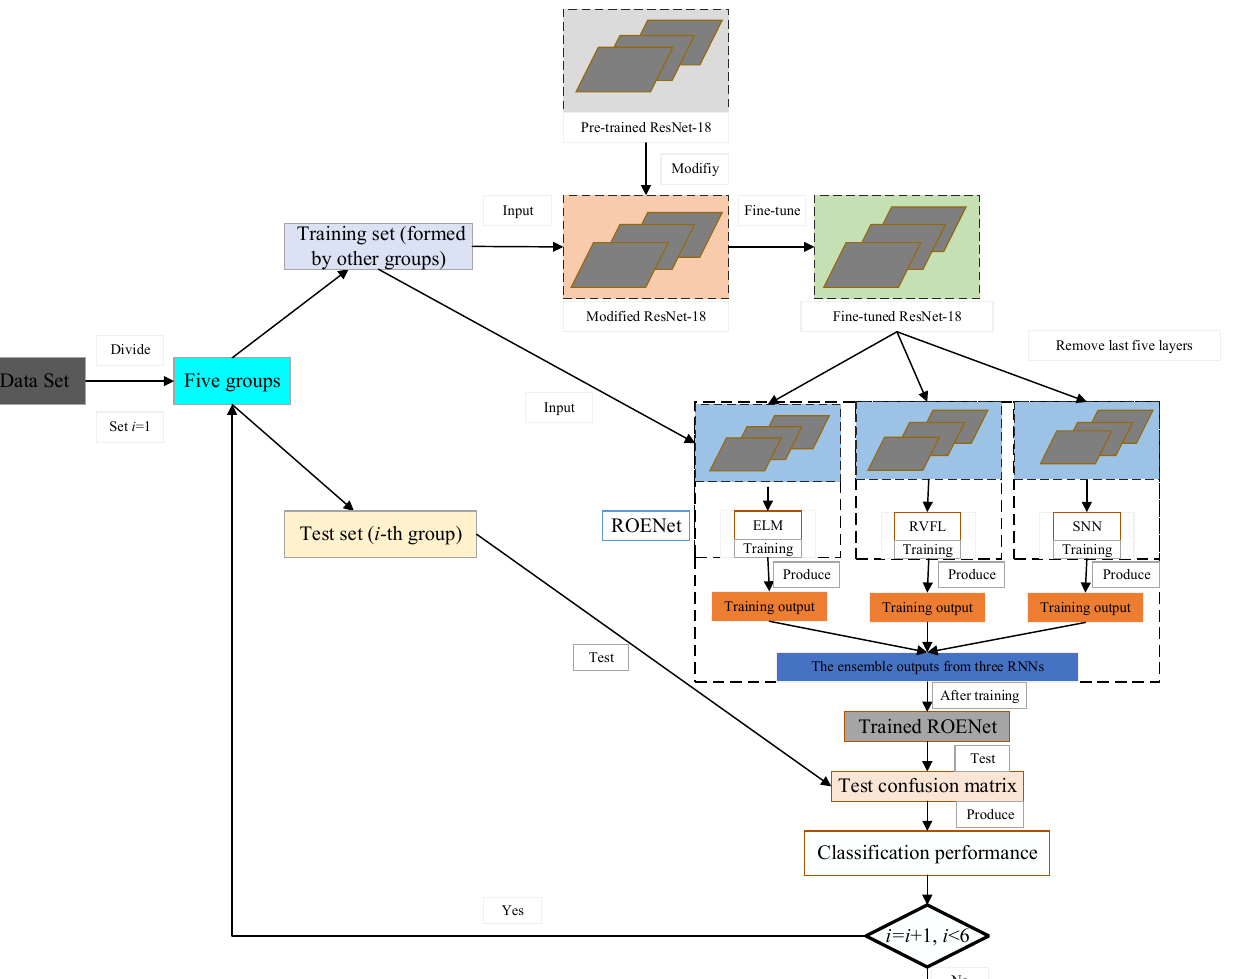
Figure 2. The flowchart of the proposed ROENet.